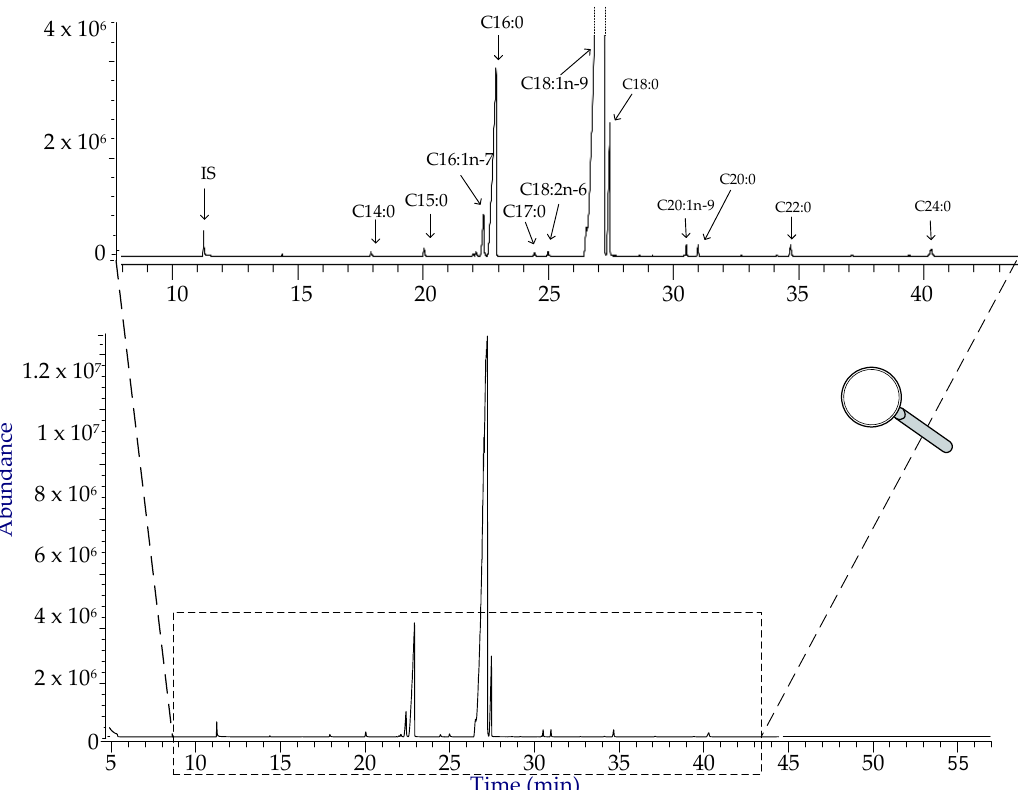
Figure 4. Representative annotated total ion chromatogram (TIC) of FAMEs in samples of Ganoderma lucidum spores.